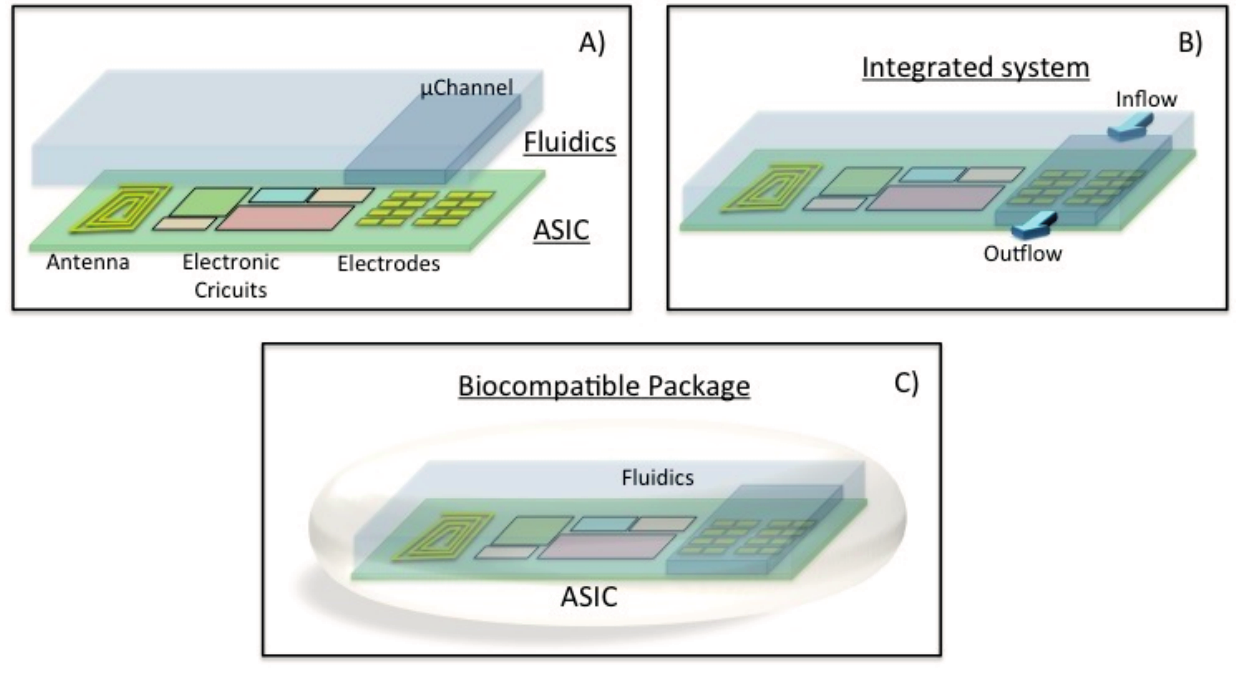
Figure 6. Schematic of the multi-parametric configurable implantable biochip